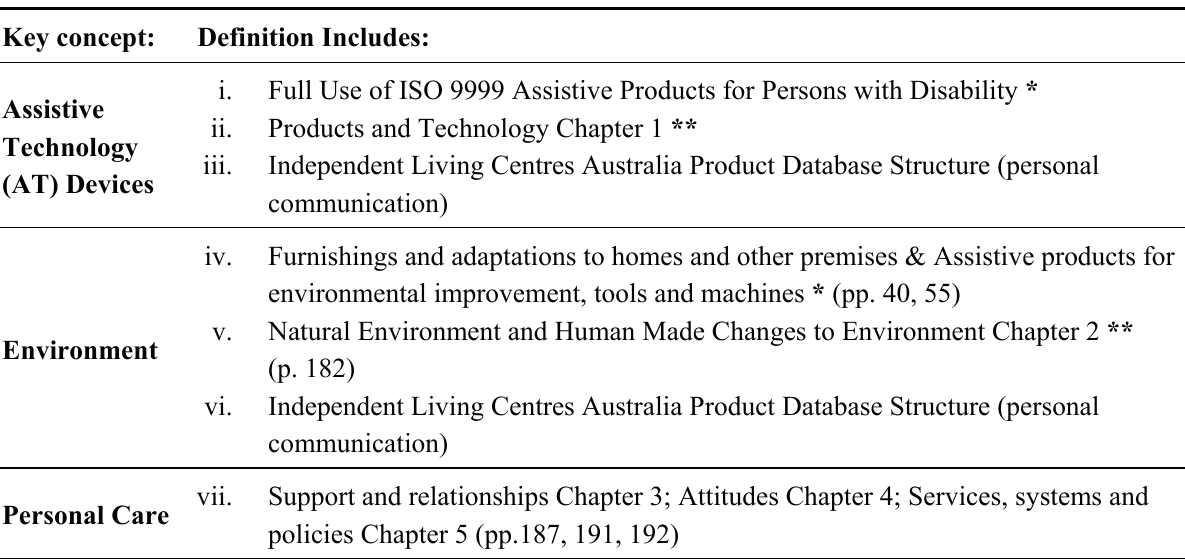
Table 1. Definitions of